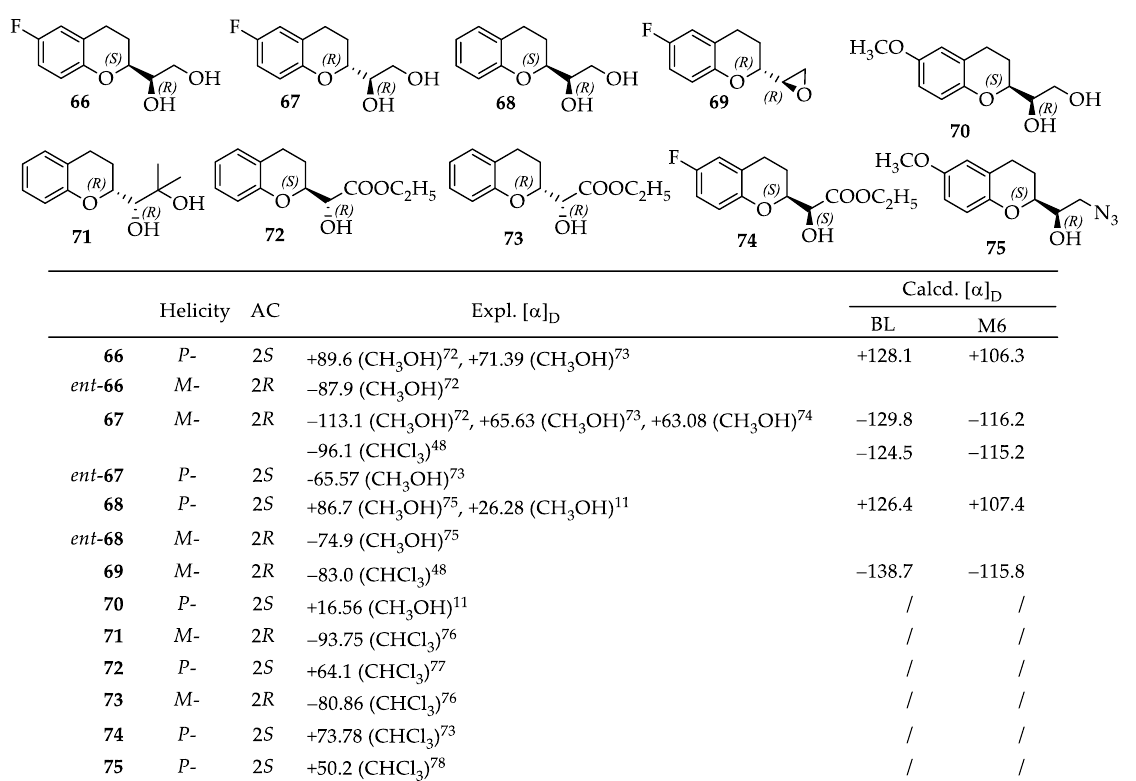
Figure 8. Some reported intermediates of nebivolol analogs 66 – 75 . BL: PCM/B3LYP/Aug-cc- pVDZ//B3LYP/6-311G(d,p), M6: PCM/M06-2X/Aug-cc-pVDZ//M06-2X/TZVP. Experimental SOR data were collected from references [11,48,72 – 78].